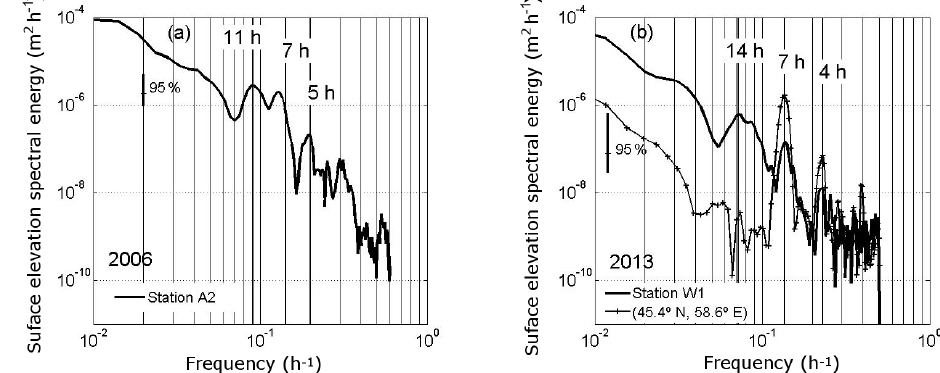
Figure 3. Spectra of the simulated surface level (a) in 2006 at station A2 and (b) in 2013 at station W1 and at 45.4 ◦ N, 58.6 ◦ E.